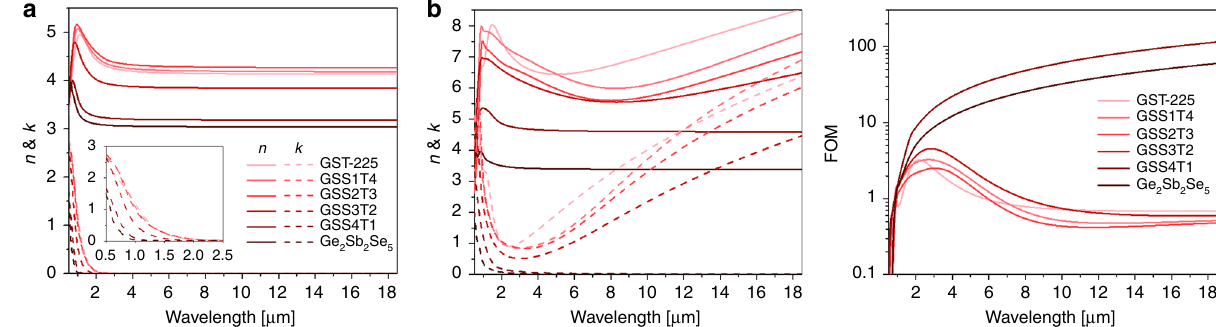
Fig. 5 Optical properties of Ge 2 Sb 2 Se x Te 5- x fi lms. a , b Measured real ( n ) and imaginary ( k ) parts of refractive indices of the a amorphous and b crystalline alloys. c Material FOM ’